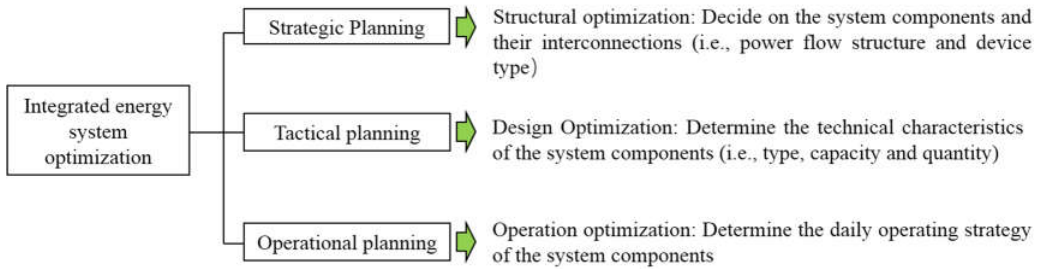
Figure 4. Optimization decision process of integrated energy system.